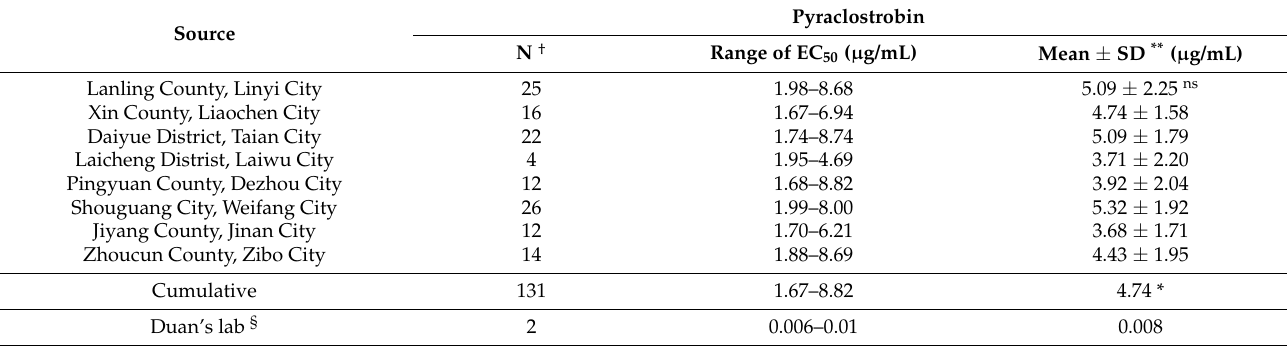
Table 2. Sensitivity of Corynespora cassiicola isolates collected from Shandong province to